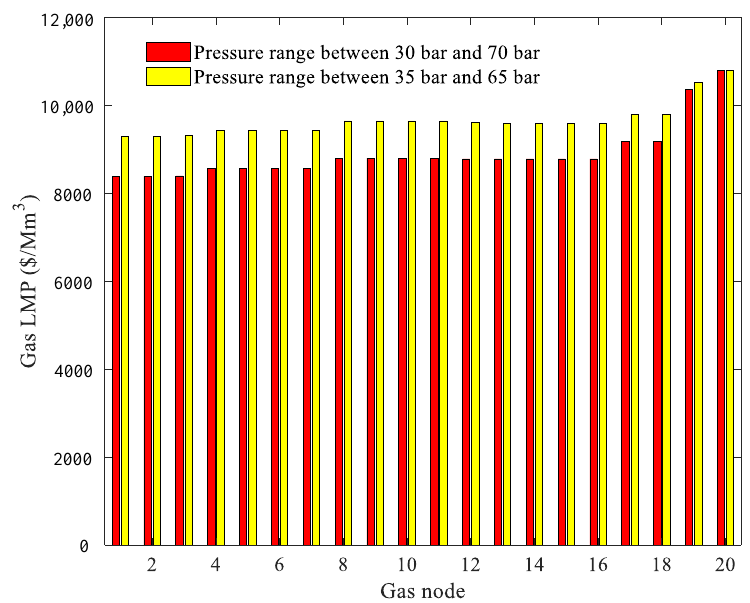
Figure 6. Case study 2: gas LMPs at the peak time period for two sets of gas pressure limits (Max TPP